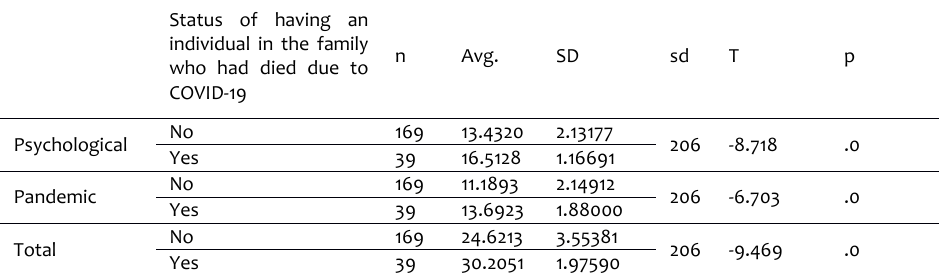
Table 7. The mean scores and t-test results of the reactions of the children to the pandemic according to the presence of having individuals who had lost their lives due to COVID-19 in the family